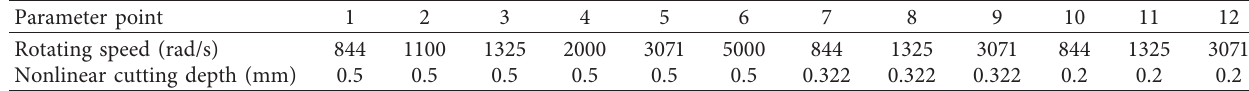
Table 2: Corresponding values at these parameter